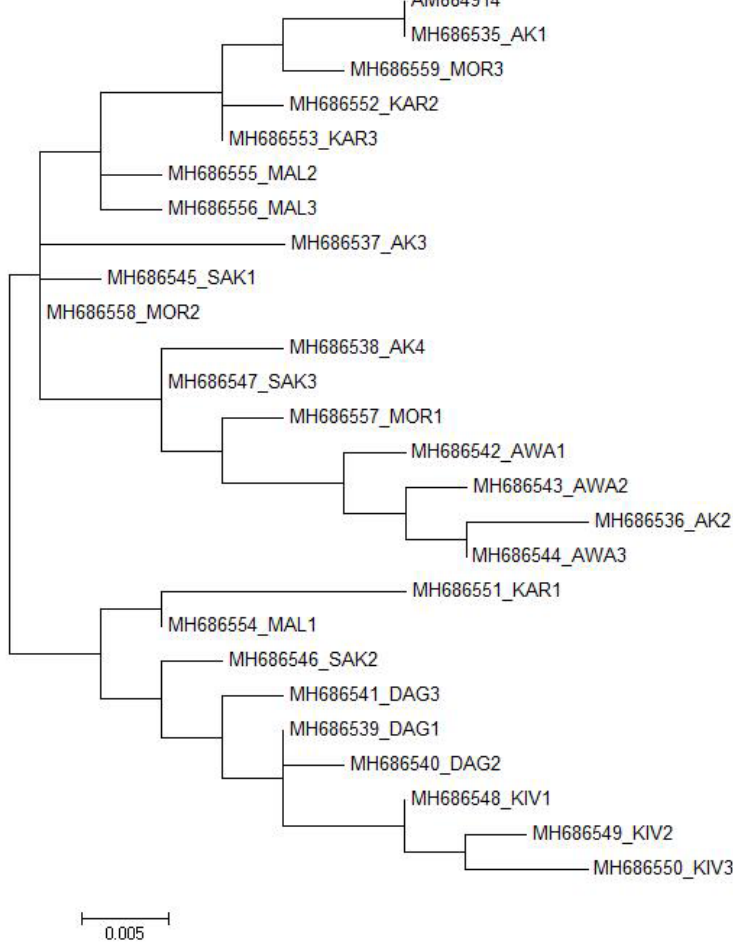
Figure 2. Maximum likelihood tree estimated under the HKY + I model for the Ovar-DRB1 gene exon 2 sequences of Turkish native sheep breeds with the AM884914 GenBank